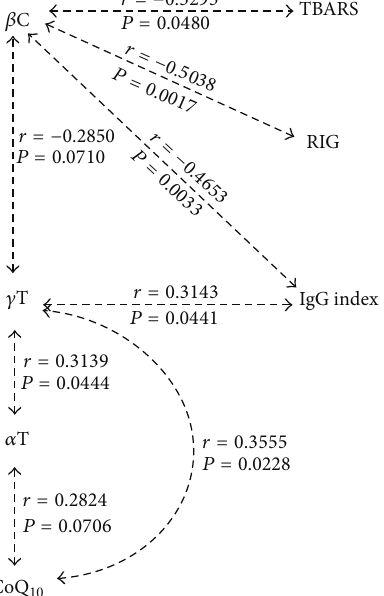
Figure 2: Spearman rank correlations among lipophilic antioxi- dants, TBARS, and intrathecal synthesis of IgG expressed by IgG index and Reiber’s index. 𝛽 C: 𝛽 -carotene, 𝛾 T: 𝛾 -tocopherol, 𝛼 T: 𝛼 - tocopherol, CoQ 10 : coenzyme Q 10 , and TBARS: thiobarbituric acid reactive substances.